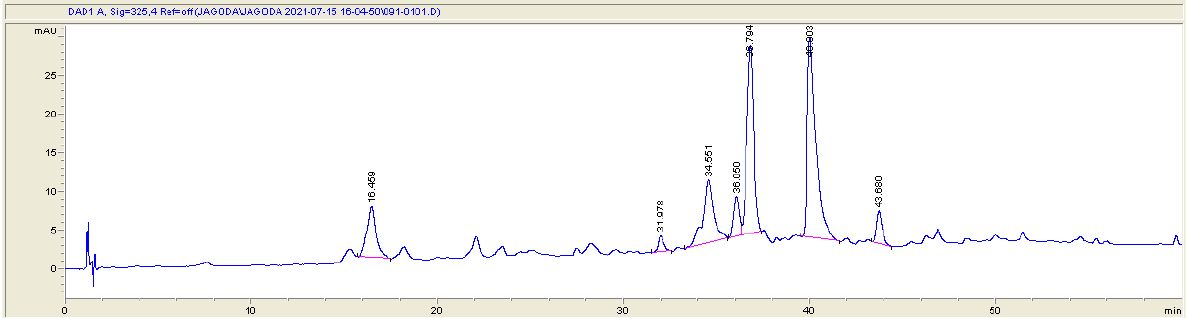
Figure 3. The chromatogram of the quantitative UHPLC analysis of V. amygdalina methanolic leaf